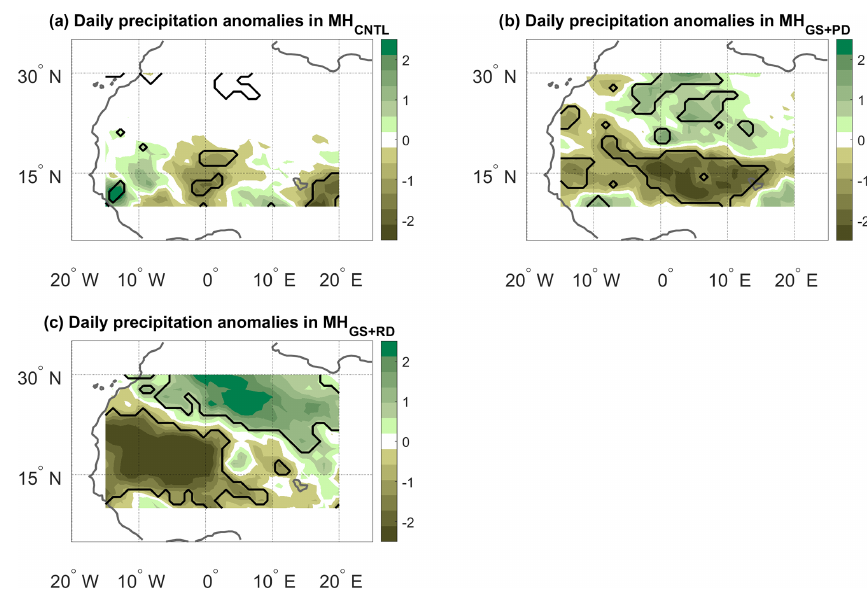
Figure A3. The same as Fig. 4 but using the domain 10–30 ◦ N, 15 ◦ W–20 ◦ E.